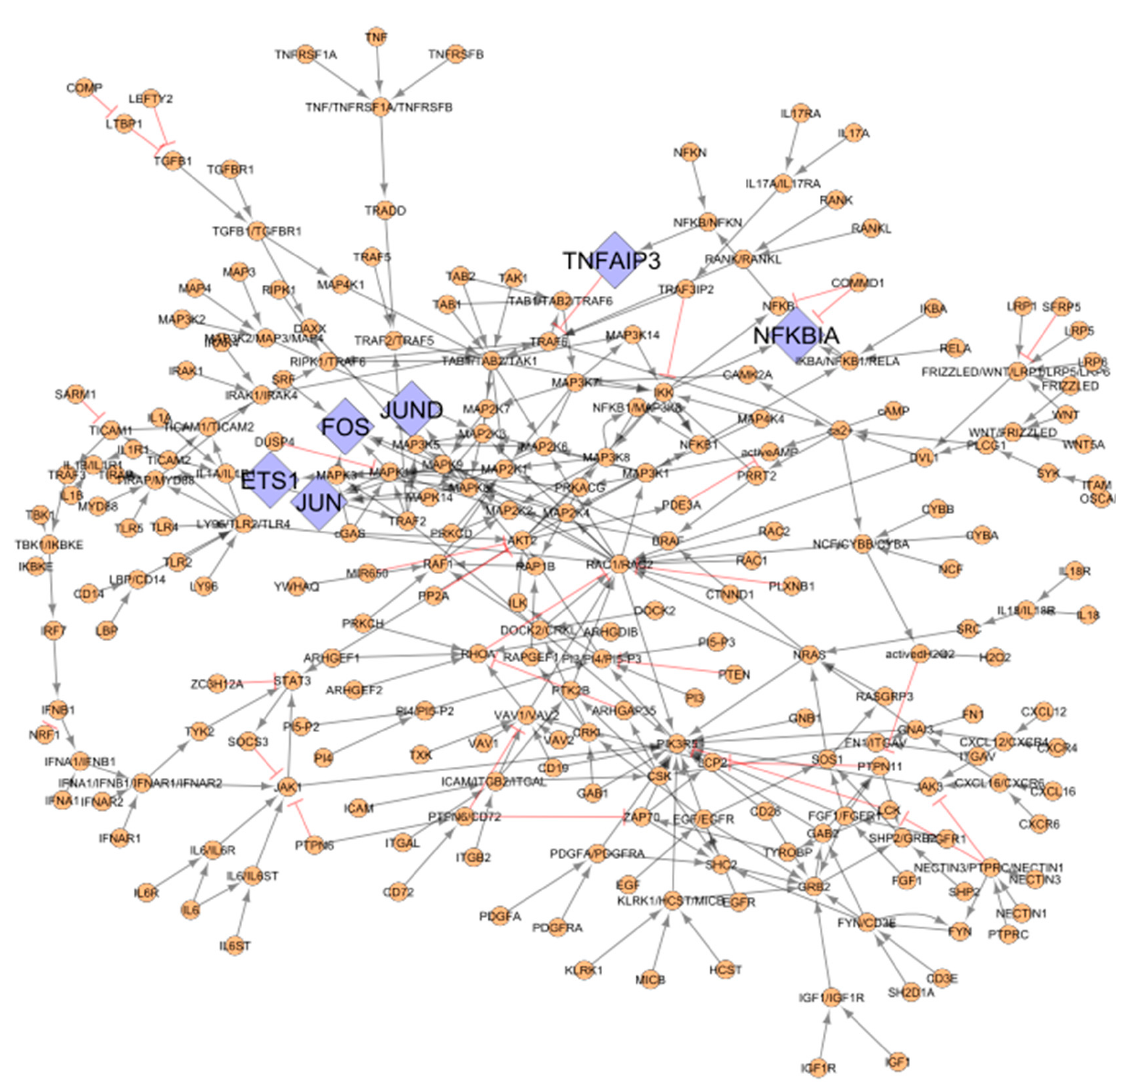
Figure 3. The upstream regulators of the matching TFs between the RA map and the CoRegNet co-regulatory network. Matching TFs from the inferred network with CoRegNet are coloured in purple (diamond shape) (6), and upstream regulators (round shape) are coloured in orange (238). Inhibitions are represented with blunt red arrows and activations with grey arrows.